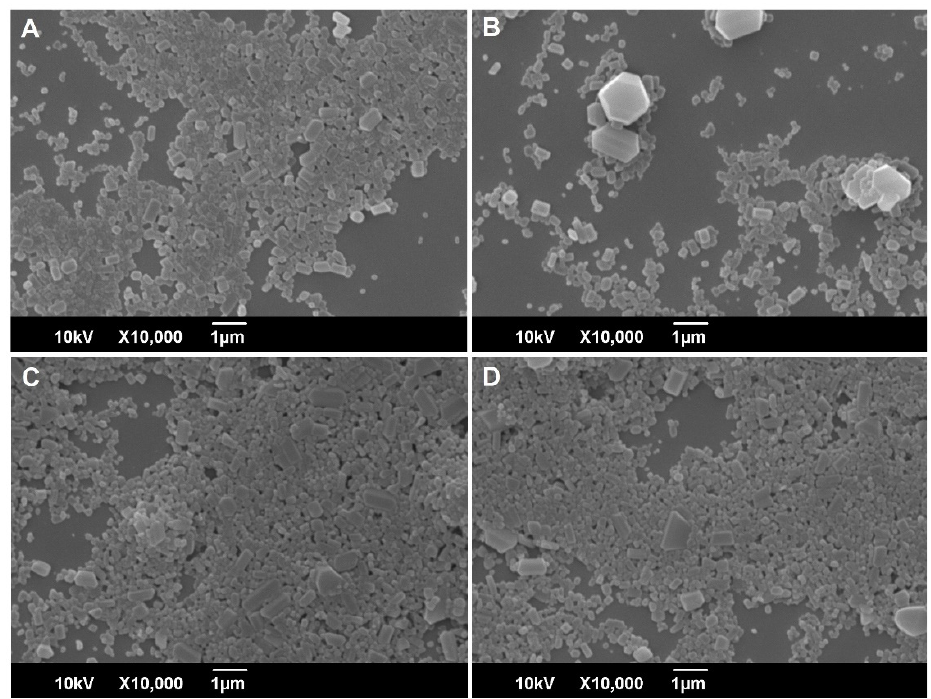
Figure 3. Scanning electron microscopy analysis of DCF NS (pH 6.0) before ( A , B ) and after ( C , D ) the jet injection across a skin specimen.